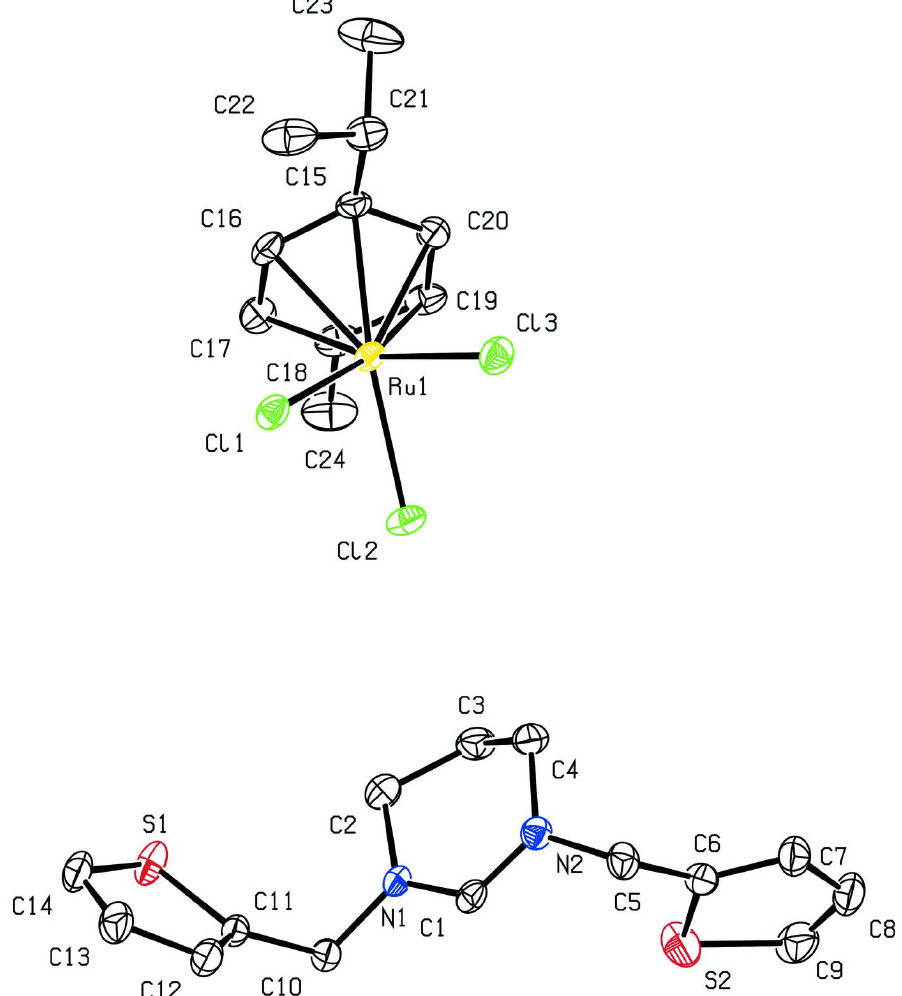
The molecular structure of the title compound, showing the atom-numbering scheme and displacement ellipsoids drawn at the 50% probability